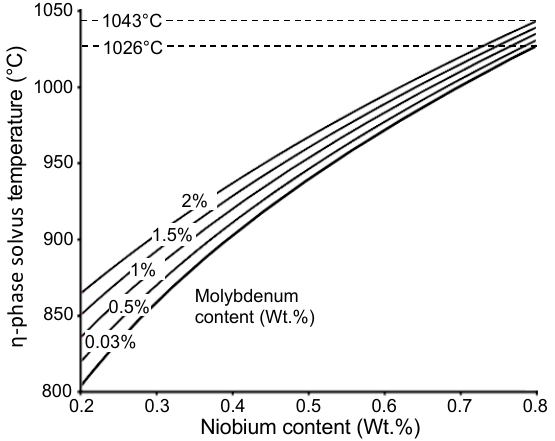
Figure 3. The simulated solvus temperature of η -phase as a function of Nb with various Mo contents (wt.%) in 0.02C-0.02N-21Cr-0.32Mn-0.2Ti base composition.